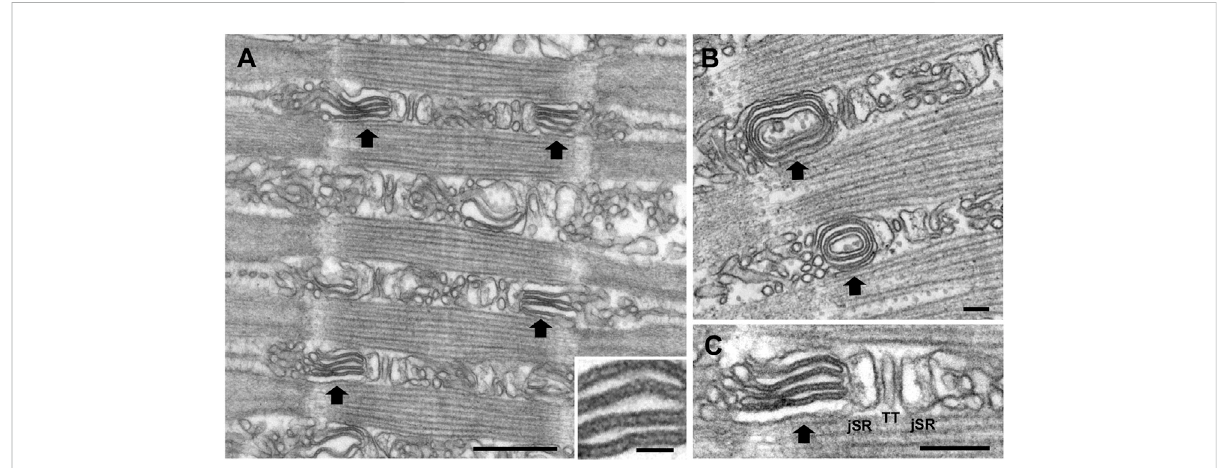
FIGURE 3 Representative EM images of sonic muscle fi bers from a humming male midshipman, showing SR stacks. At random intervals within the fi bers, the intermyo fi brillar spaces are occupied by fl at SR cisternae arranged into tight stacks (large black arrows) forming either fl at aggregates (A) or concentric circles (B) . The stack components are in direct continuity with the SR elements (jSR) constituting the lateral sacs of the triad (C) (TT i.e., T-tubule). The spacing between the surfaces of cisternae is apparently constant and crossed by frequent links or tethers (inset in A). The stacks are found in the sonic swimbladder muscles of all territorial male fi sh, but more frequently in muscles that have been used for an extended period of humming, as in the fi sh depicted here (see also Table 2). Scale bars: 0.5 μ m (A) , 0.05 μ m (inset), 0.1 μ m (B) , 0.2 μ m (C) .